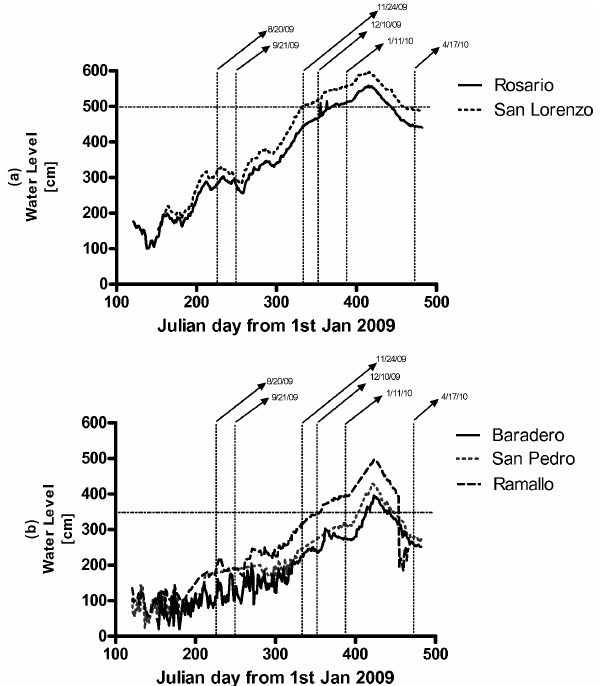
Fig. 4. Water level (cm) measured in the five stations as a function of time. The horizontal lines indicates alert river water level and vertical dotted lines indicate AMSR-E acquisition dates. (a) Rosario and San Lorenzo and (b) Baradero, San Pedro and Ramallo